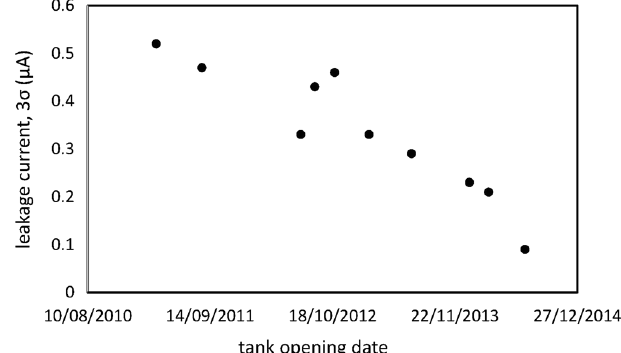
FIG. 2. Photograph (left) and schematic sketch (right) of half of the 14UD double unit. The flexible connections between pairs of tube resistors are removed. The unit is completely stripped of equipotential rings.